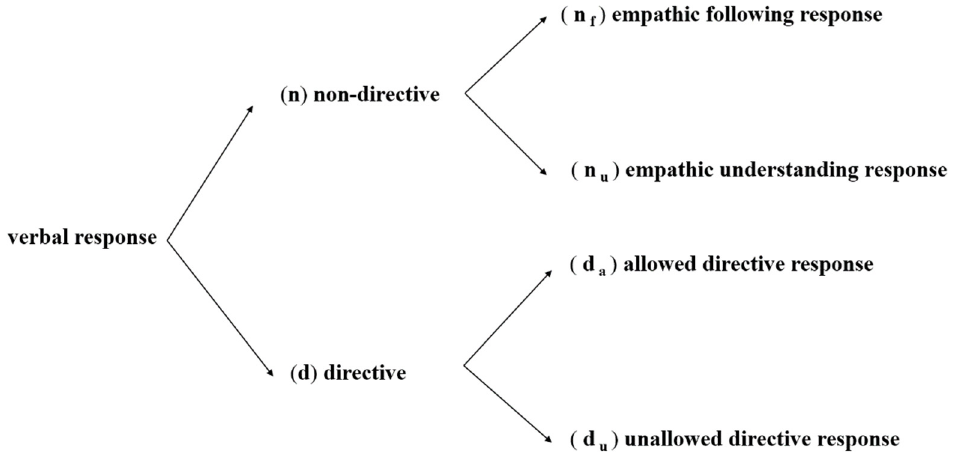
Figure 1. Four types of verbal responses, as described by Brodley (1999).